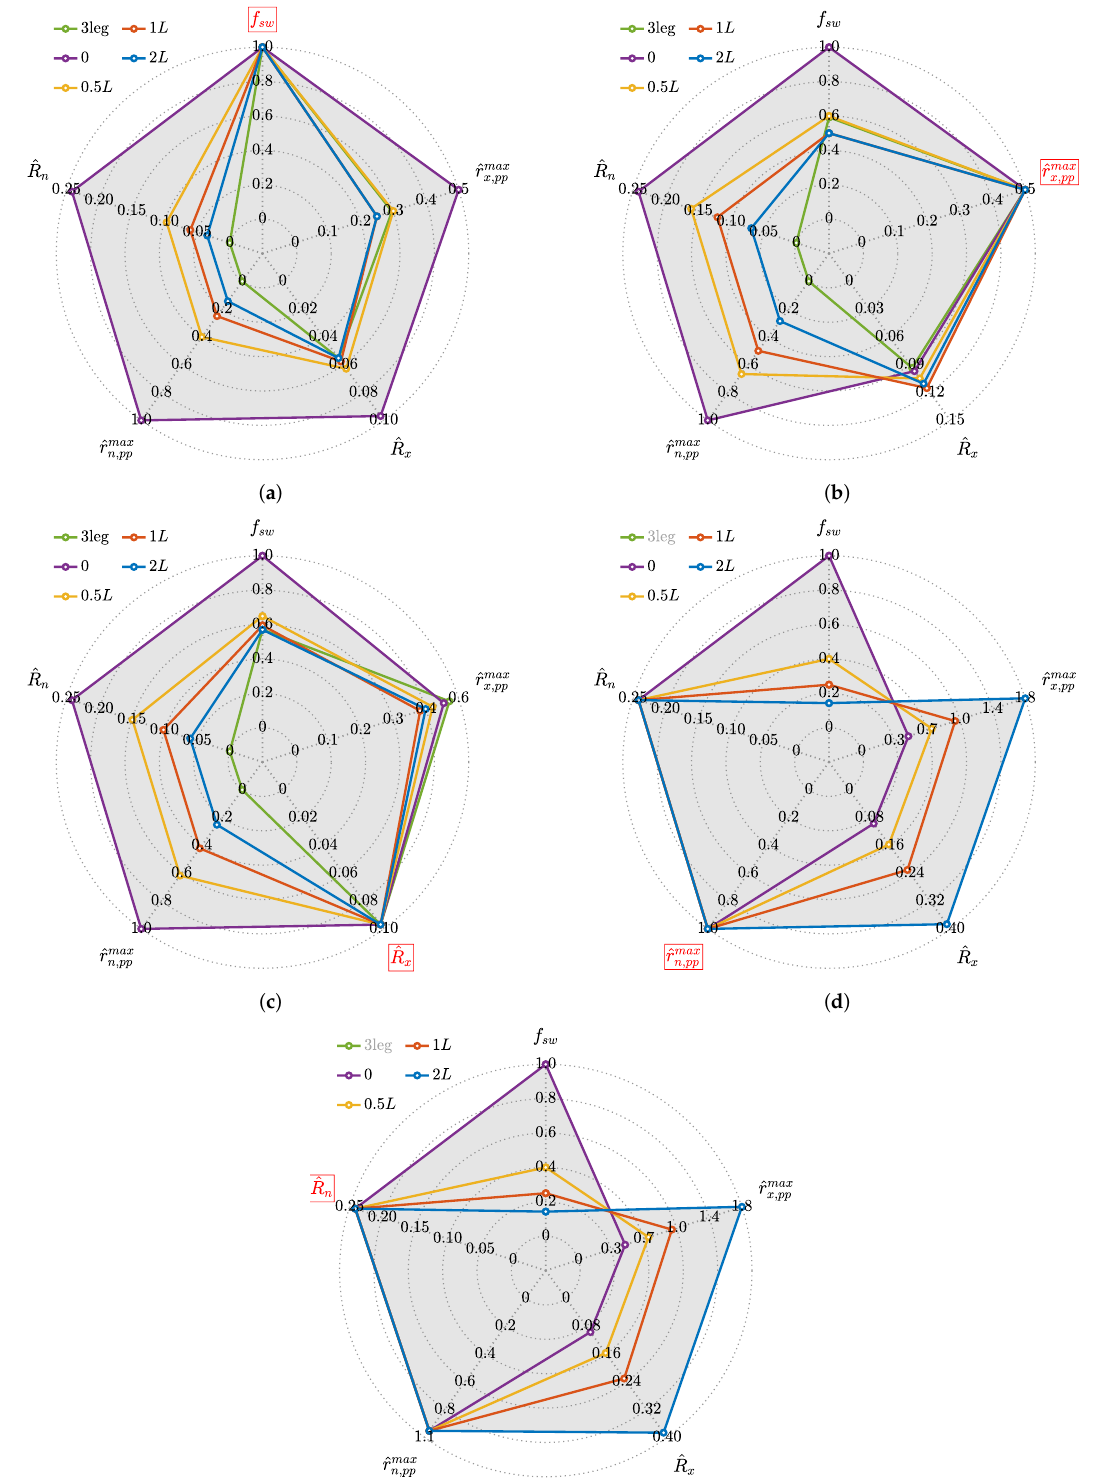
Figure 16. Kiviat (radar) diagrams depicting current-ripple-related performances for compared converter topologies at ϕ = 0 and m = 0.5 and identical fixed metrics: ( a ) switching frequency; ( b ) maximum, normalized, peak-to-peak phase switching current ripple; ( c ) normalized RMS value of a phase switching current ripple; ( d ) maximum, normalized, peak-to-peak neutral switching current ripple; and ( e ) normalized RMS value of neutral switching current ripple.